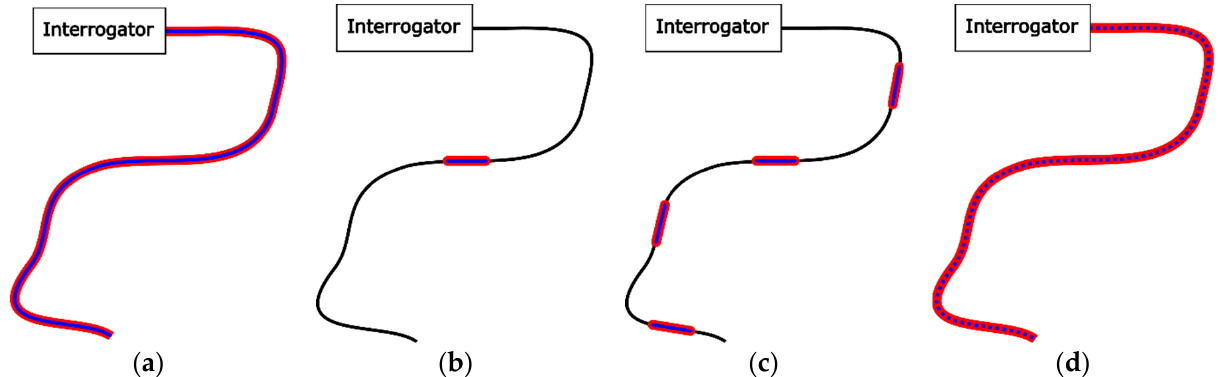
Figure 6. Graphical illustration of different FOS concepts: integrated ( a ), point ( b ), quasi-distributed ( c ), and distributed ( d ). The black line illustrates the fiber optic link. The red and blue lines represent the sensing length and measurement points respectively.